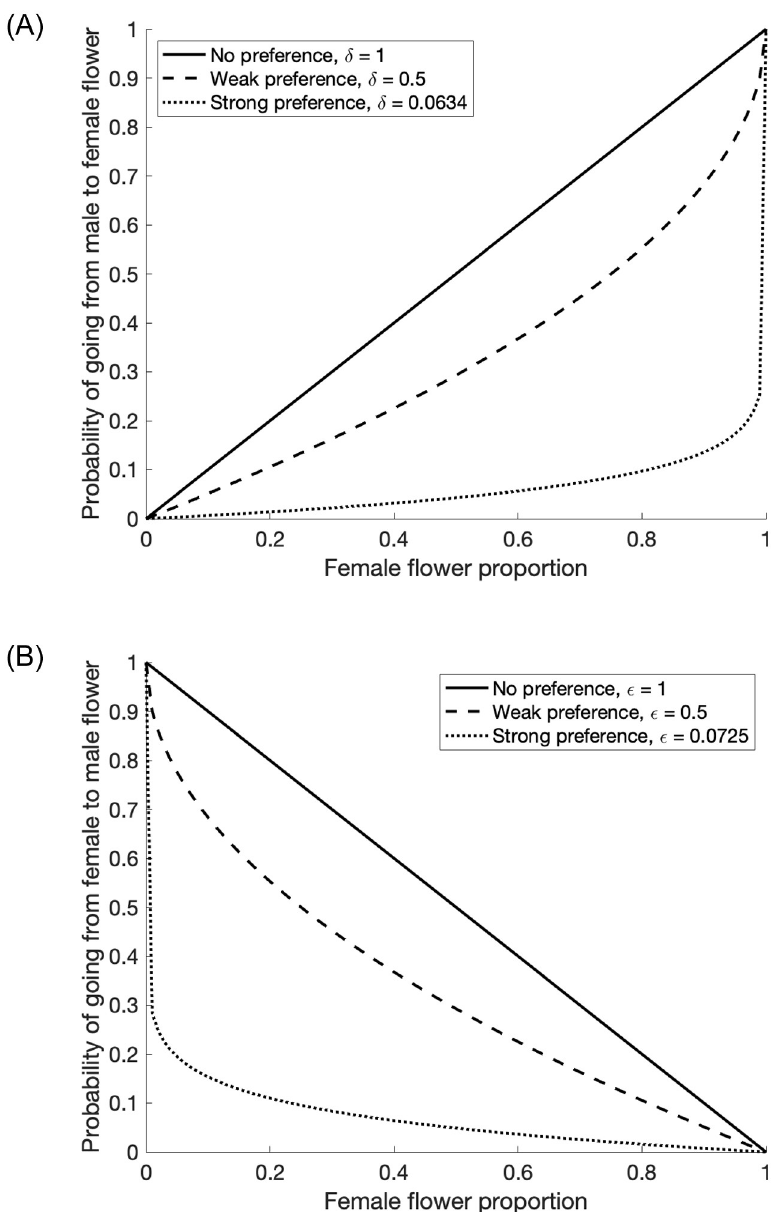
Fig 3. Movement probabilities for (a) pollinators on male flowers switching to a female flower and (b) pollinators on female flowers switching to a male flower for strong, weak, and no preferences in paramters δ and � . Values for strong preferences were used for the analyses in this paper, details are described in the Parameterization section. Note that a strong preference for remaining on the same type of flower corresponds with a low probability of switching between flower